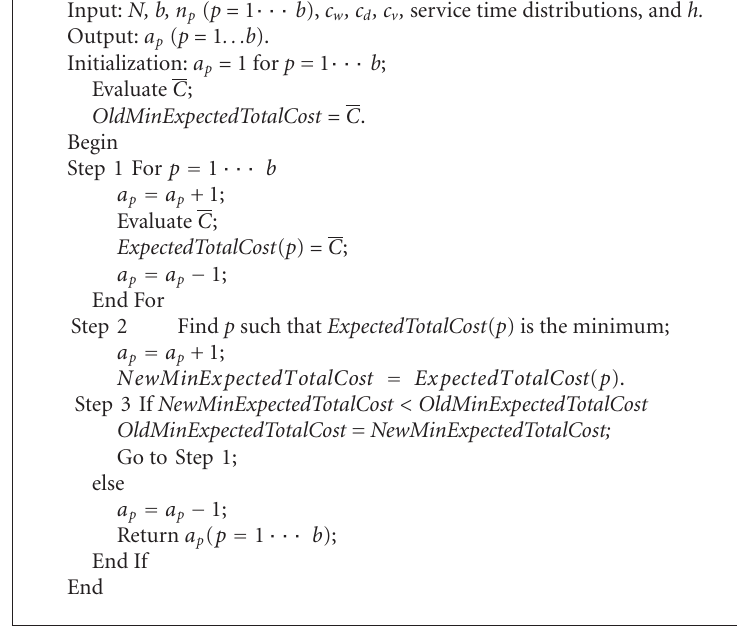
Algorithm 1: Simulation-based heuristic algorithm.